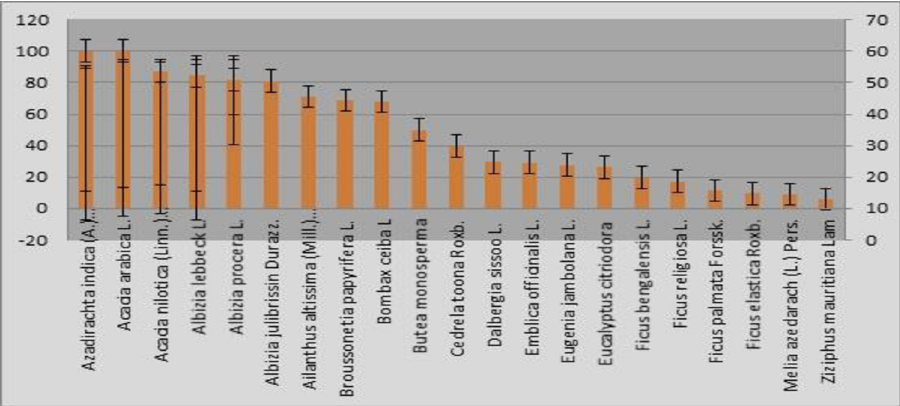
Fig 4. ROP value of indigenous plants species from Shiwalik mountaineous range of District Bhimber AJK, Pakistan.